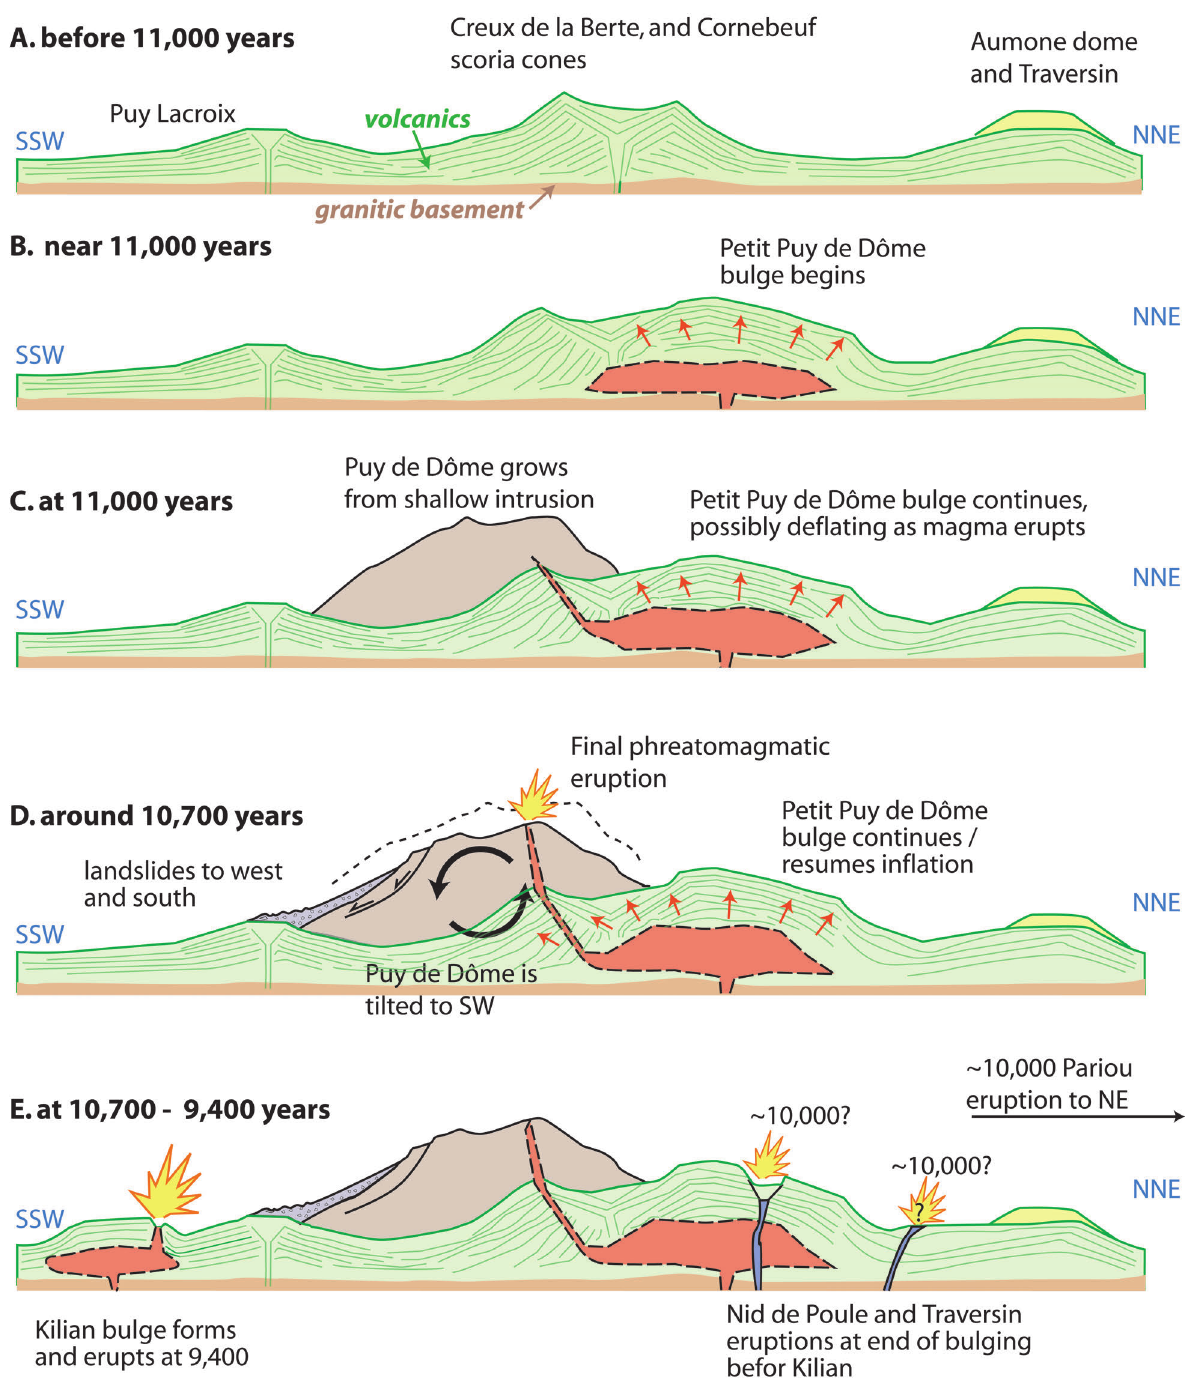
Figure 14: Summary cartoon of the sequence of events around the Puy de Dôme. [A] Pre-Puy de Dôme before 11,000 years BP. The area is mostly older scoria cones, with one trachyte dome, the Petit Suchet, emplaced a few thousand years before. [B] Start of activity with shallow intrusion starting to create the Petit Puy de Dôme bulge. [C] Trachytic magma breaks through on the south of the bulge to allow the Puy de Dôme to grow. We note that there was probably a deflation phase of the Petit Puy de Dôme during the e ff usion of the dome, although no clear evidence has been left of this. The dome gains a carapace of ash towards the end [Boivin et al. 2017]. [D] The cooled Puy de Dôme is then tilted by continued growth of the Petit Puy de Dôme, and a small summit eruption occurs around 10,700 BP. [E] Activity stops, and a small trachyandesitic eruption cuts the Petit Puy de Dôme (Nid de la Poule) and possibly a small vent opens on the Traversin. This activity may have occurred at about 10,000 years with the Pariou eruption. Then at 9,400 BP the whole area is covered by Kilian eruption